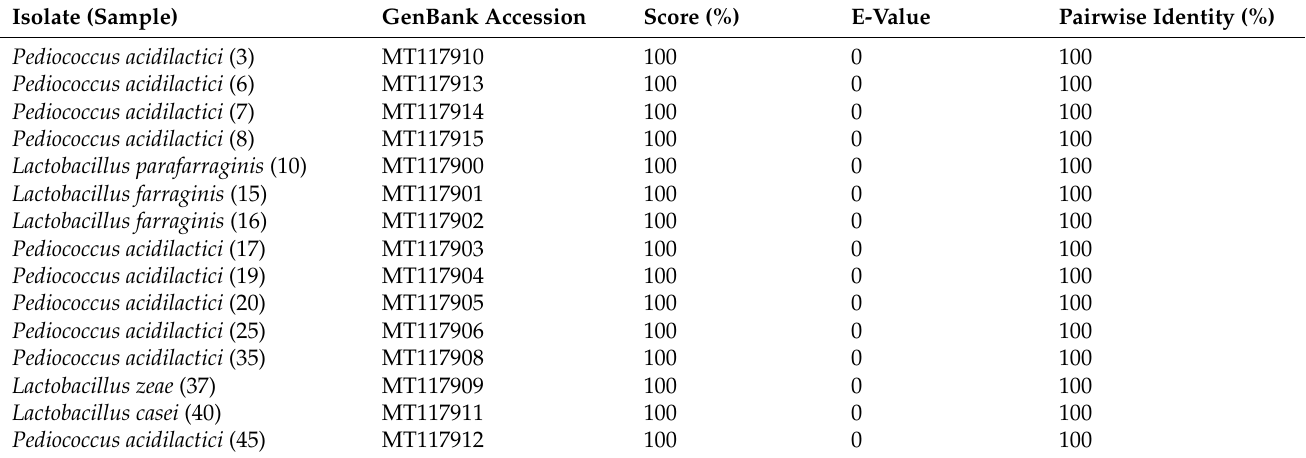
Figure 1. Distribution of LAB species at the beginning of the on-farm cocoa bean fermentation, Tomé-Açu, PA, Brazil, 2017. Table 1. Lactic acid bacteria identified at the beginning of the on-farm cocoa bean fermentation, Tomé-Açu, PA, Brazil, 2017.